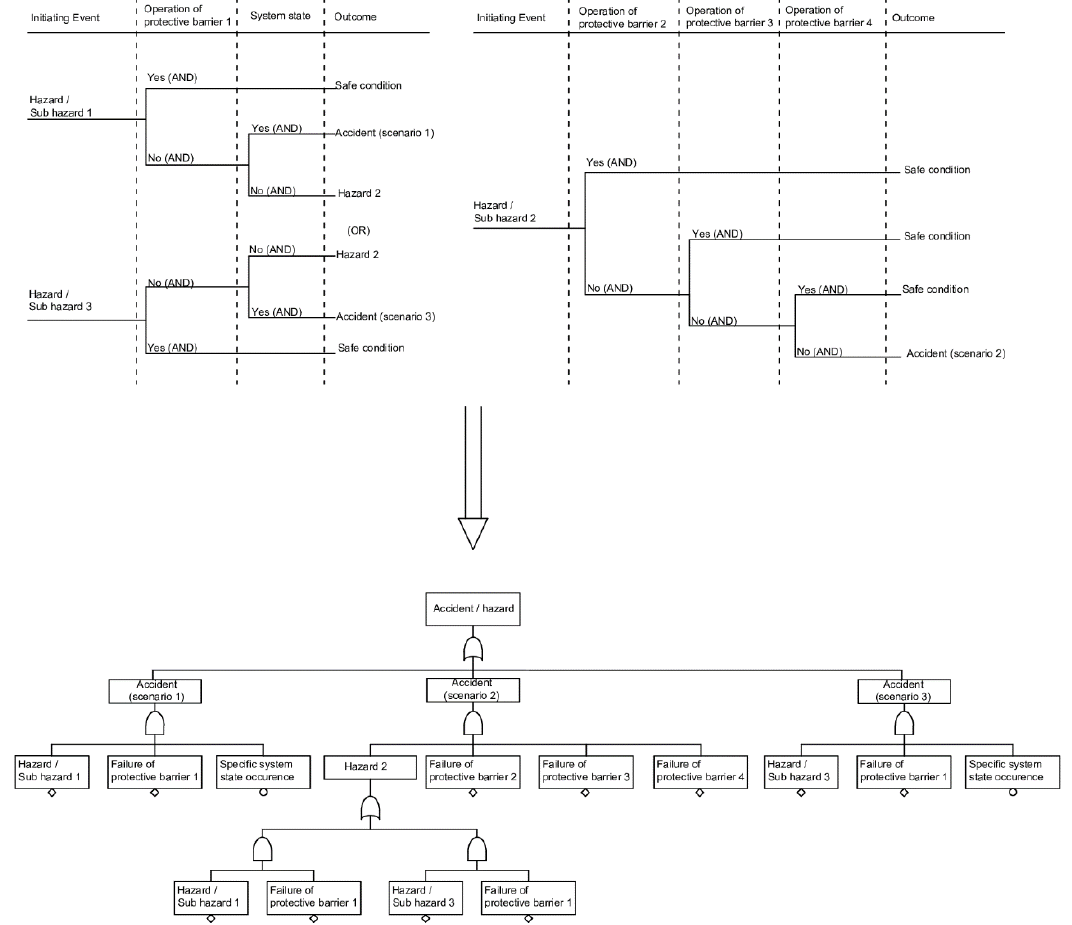
Figure 4. “Event Trees” transformation into a Fault